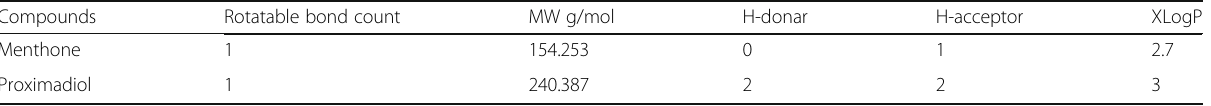
Table 4 Phytochemical properties of two selected compounds found from CML extract trough GC-MS analysis